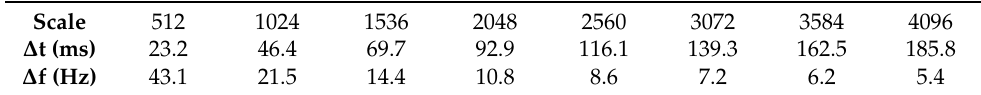
Table 1. The scales and the corresponding time and frequency